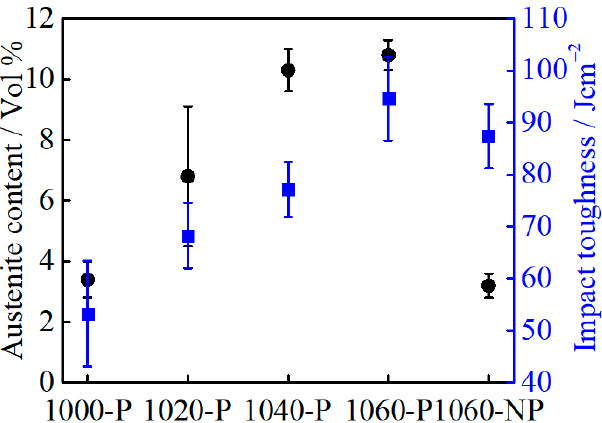
Figure 13. The relationship between retained austenite volume fraction and impact toughness.